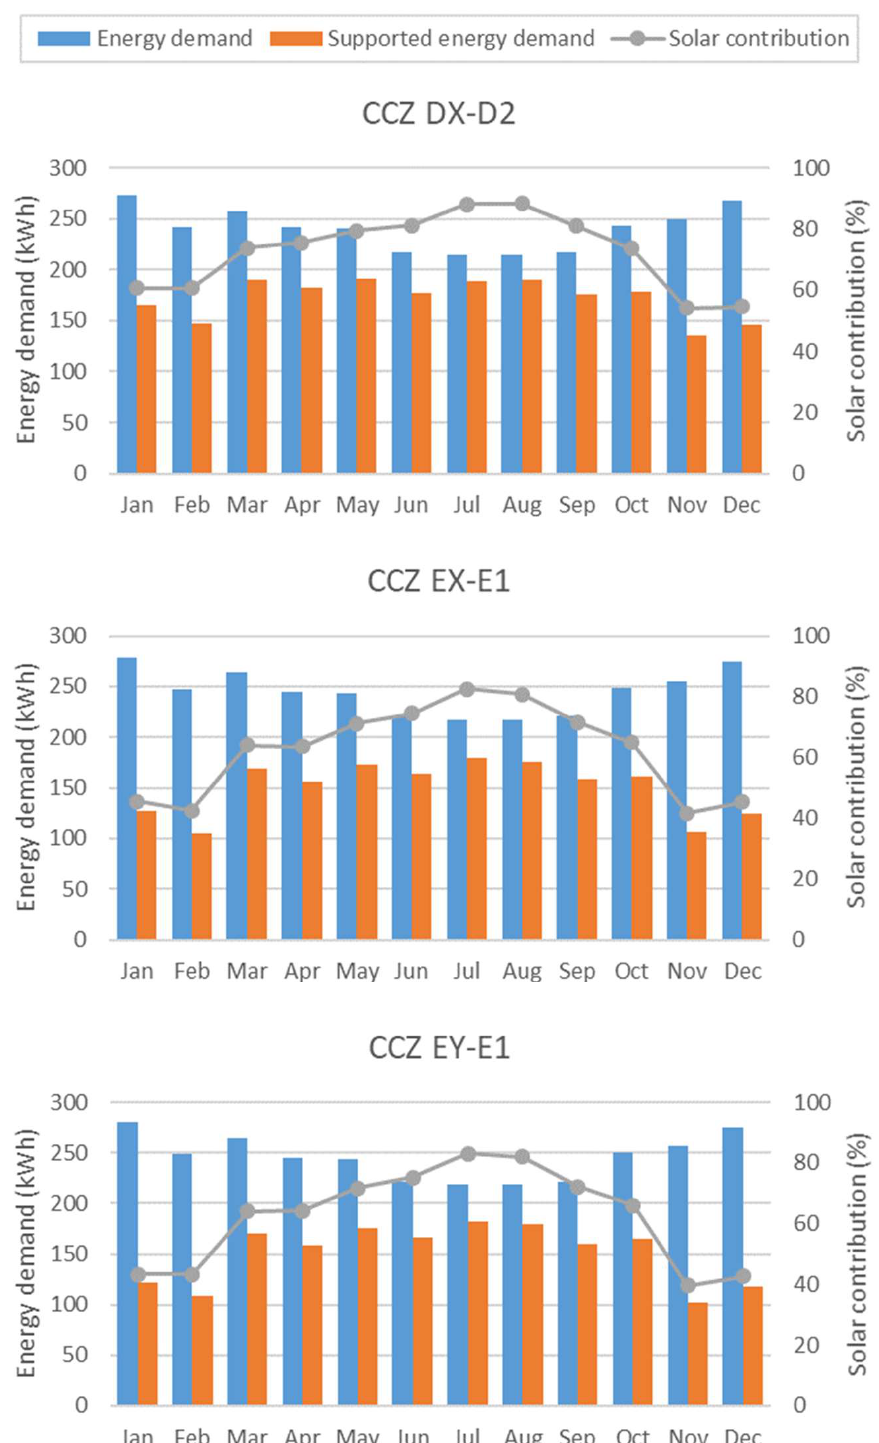
Figure A1. Monthly DHW energy demand, in kWh, monthly DHW energy demand met by the solar thermal system, in kWh, and monthly solar contribution, in %, in each CCZ.